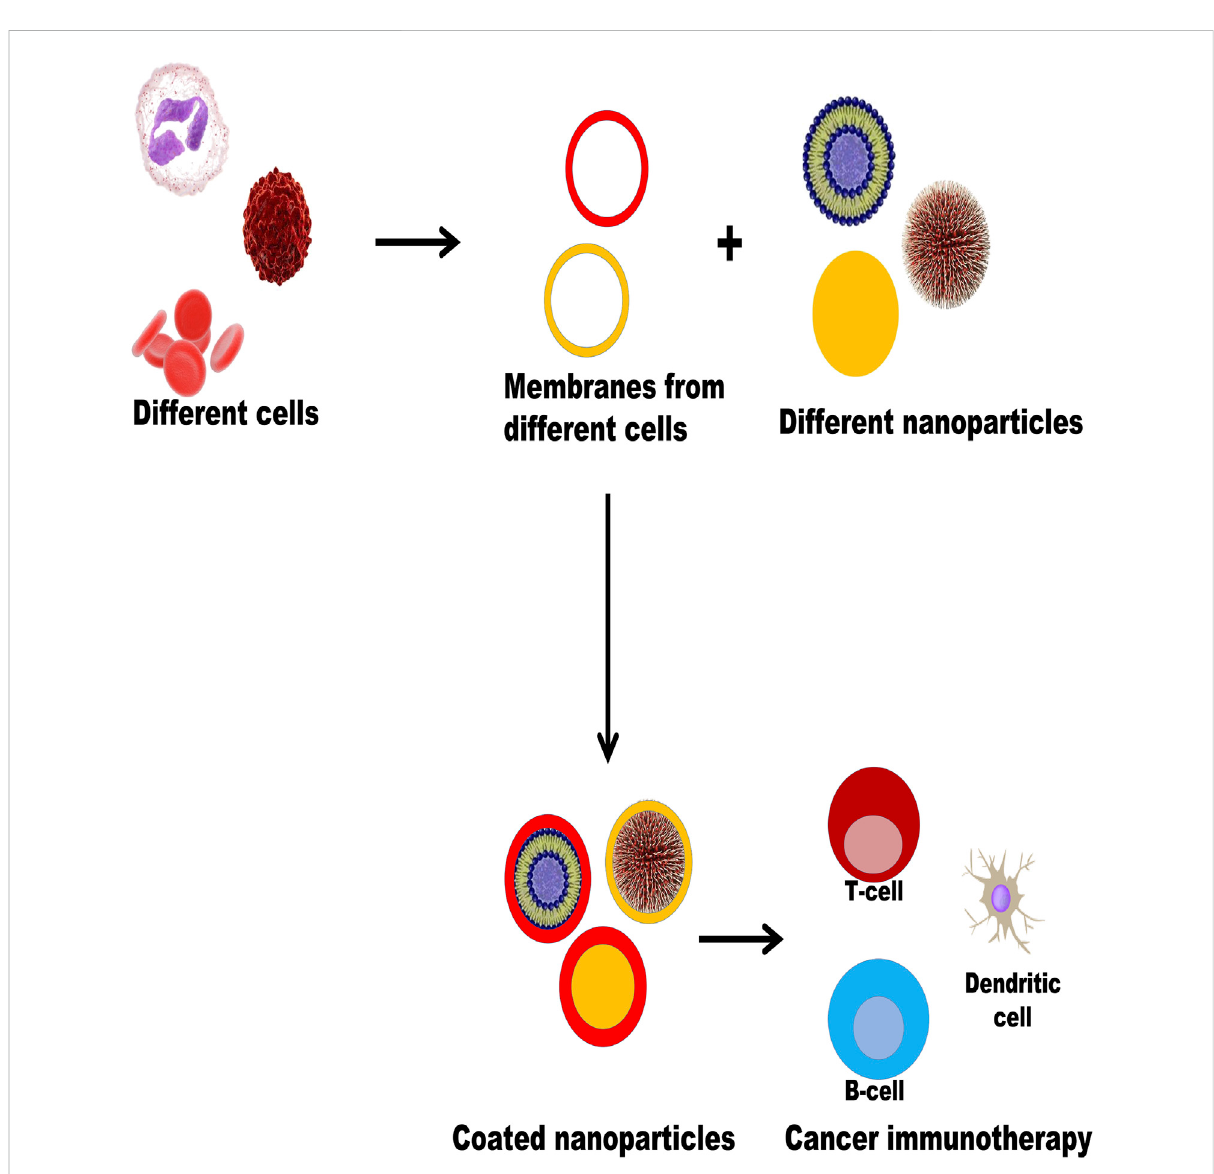
FIGURE 2 Illustrates different plasma membrane coating on different nanoparticles for cancer